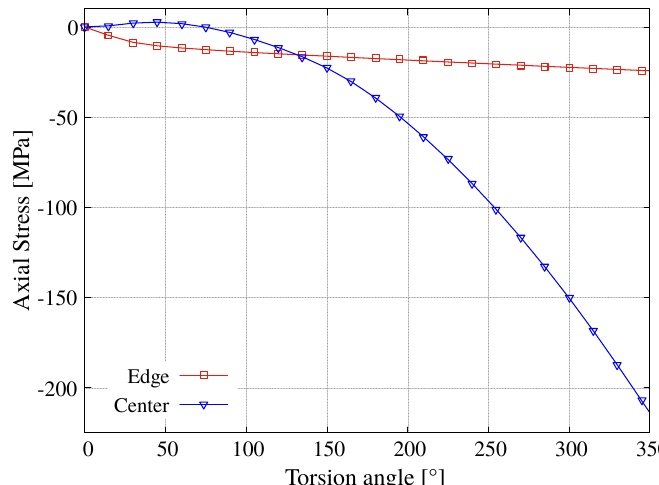
Figure 18. Numerical radial profiles for the longitudinal stress σ zz in plane 1 for different angular